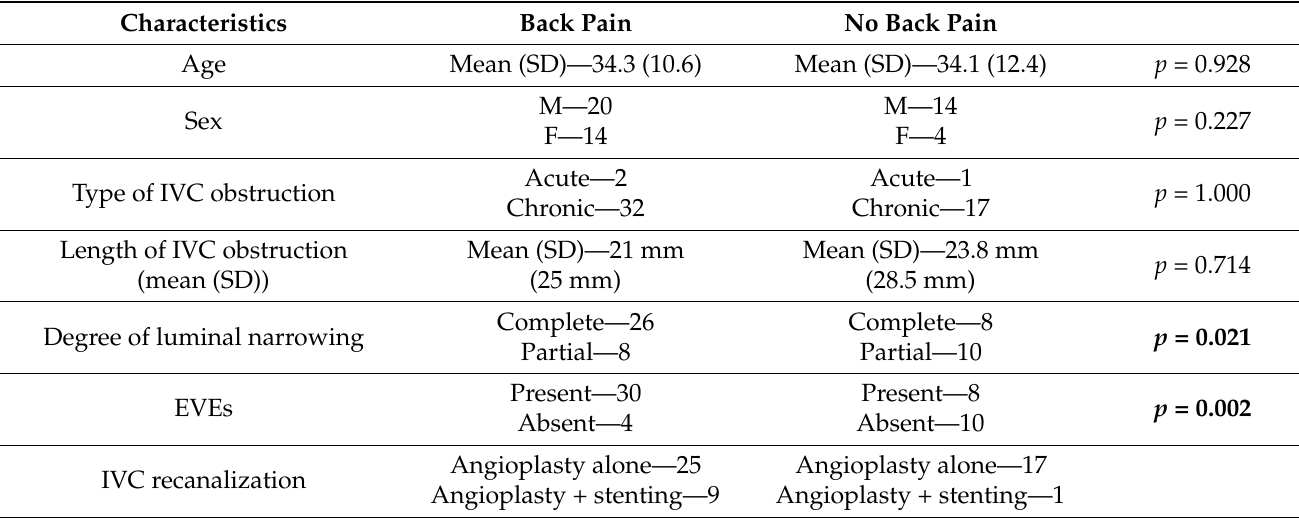
Table 2. Characteristics of patients with and without back pain ( n = 52).